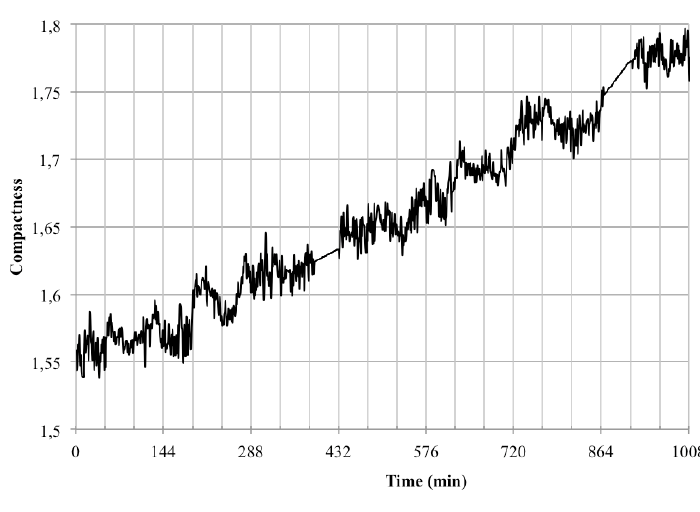
Figure 16. Compactness of Opuntia